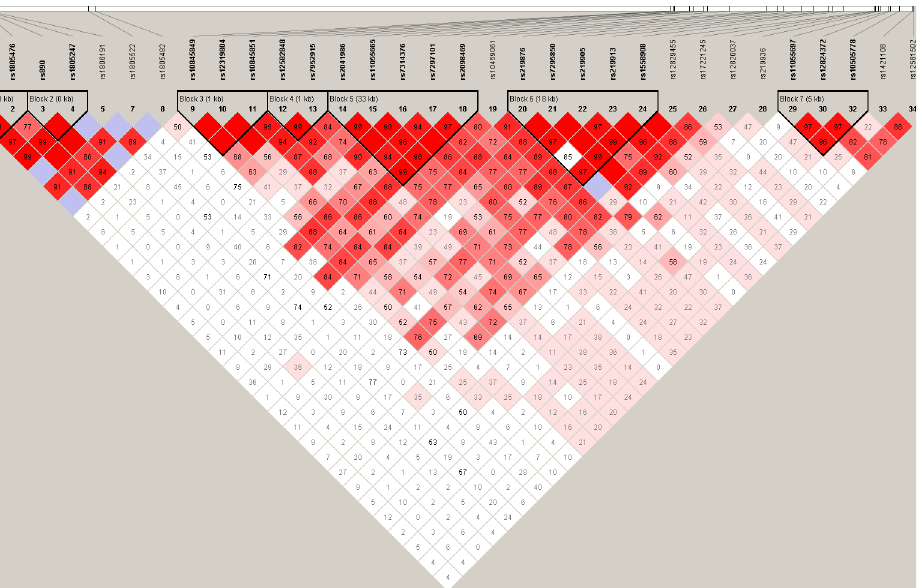
Fig 1. Haplotype block structure of the GRIN2B gene in both SZ patients and health controls. Thirty-four SNPs formed seven LD blocks. The index association SNP is represented by a diamond. The color of the remaining SNPs (circles) indicates LD with the index SNP based on pairwise r 2 values from our data.